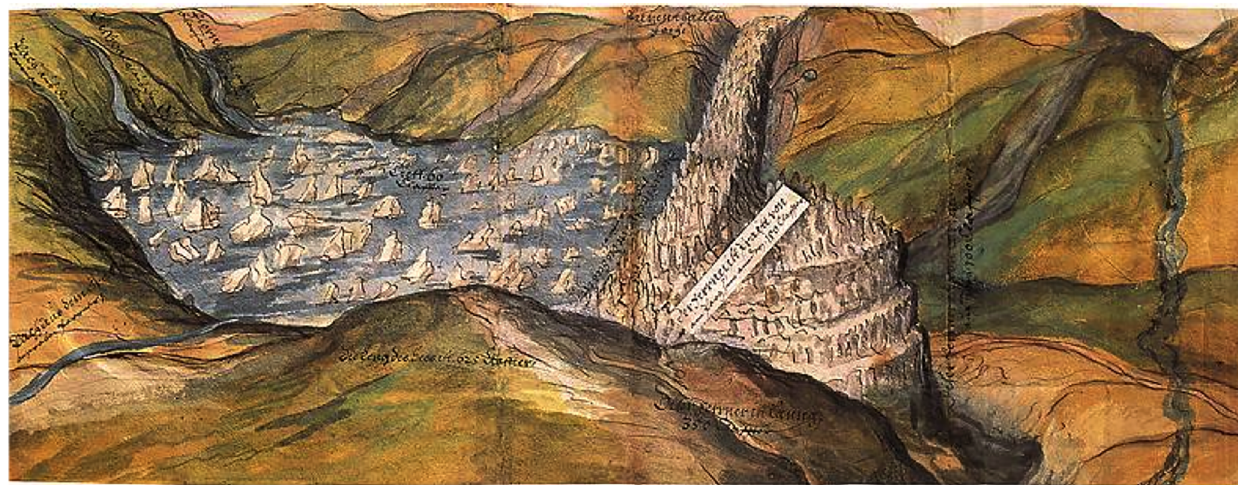
Figure 1. The “Rofentaler Eissee” in 1601, the first known image of a glacier worldwide. Painted in water colors by Abraham Jäger. The original is in the Tiroler Landesmuseum Ferdinandeum in Innsbruck. From Nicolussi (1990).